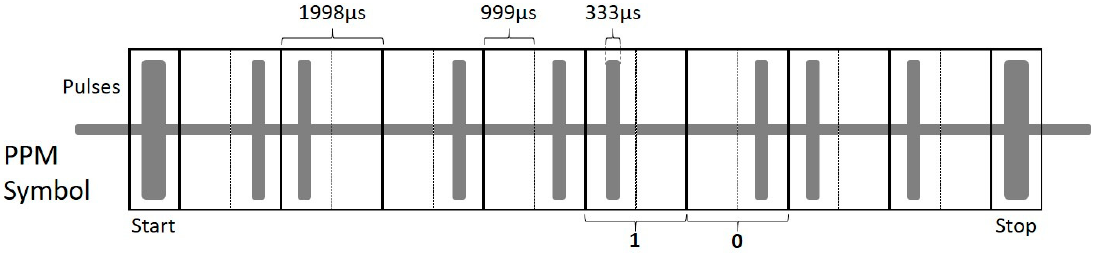
Figure 8. PPM symbol codification scheme for a sequence of 01001011 (4BH) data.